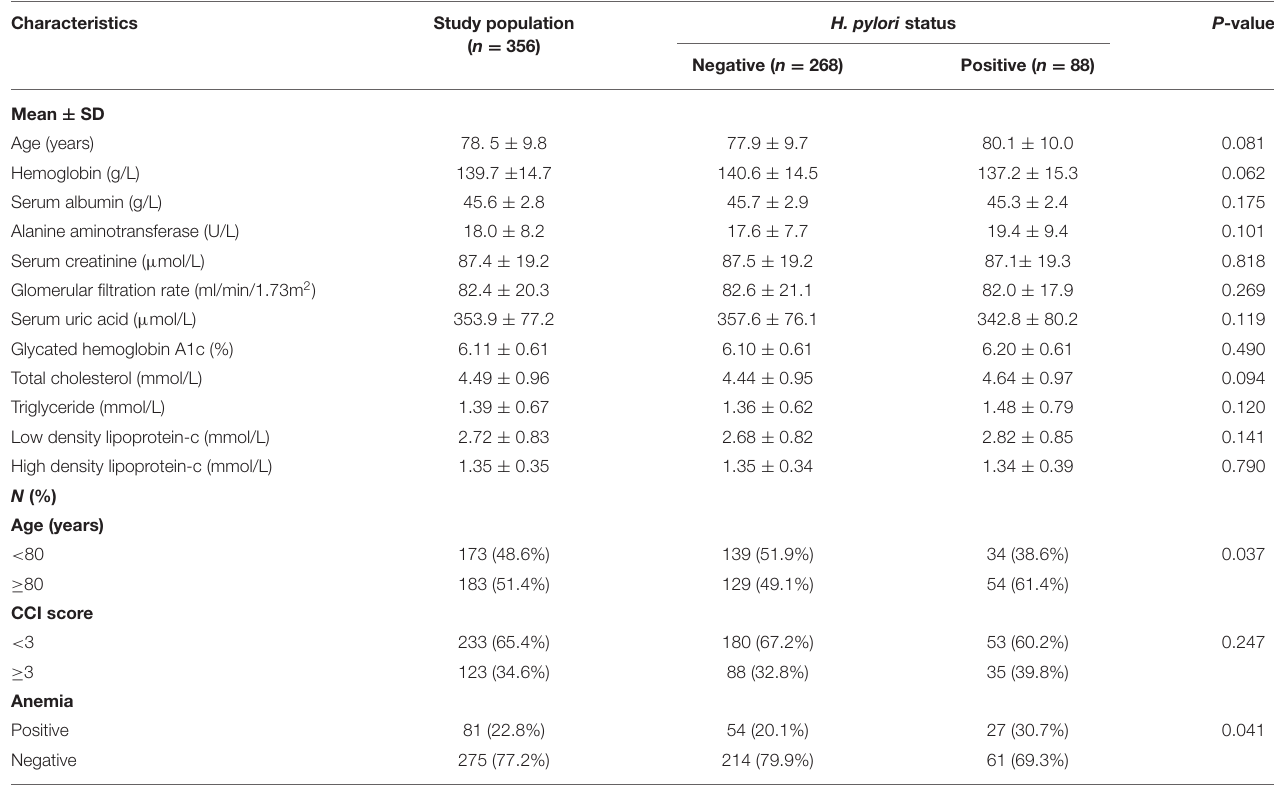
TABLE 1 | Demographic information of participants at the beginning of the study.